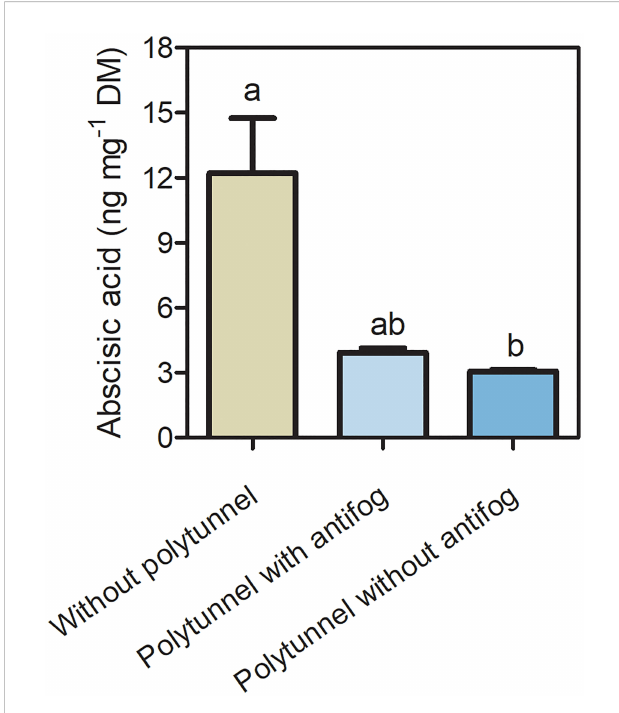
FIGURE 6 Phytohormone ABA content in lettuce. Abscisic acid content (ng mg -1 DM) in lettuce grown without or under polytunnels with and without antifogging additives. The fi rst experimental repetition in April is shown. The data are expressed as mean ± SE (n = 4). Different letters indicate signi fi cant differences (p ≤